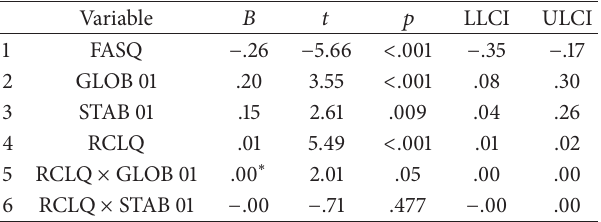
Table 4: Predicting Depressive Symptoms from the interaction between negative attributional styles and recent life changes: sum- mary of a linear mixed